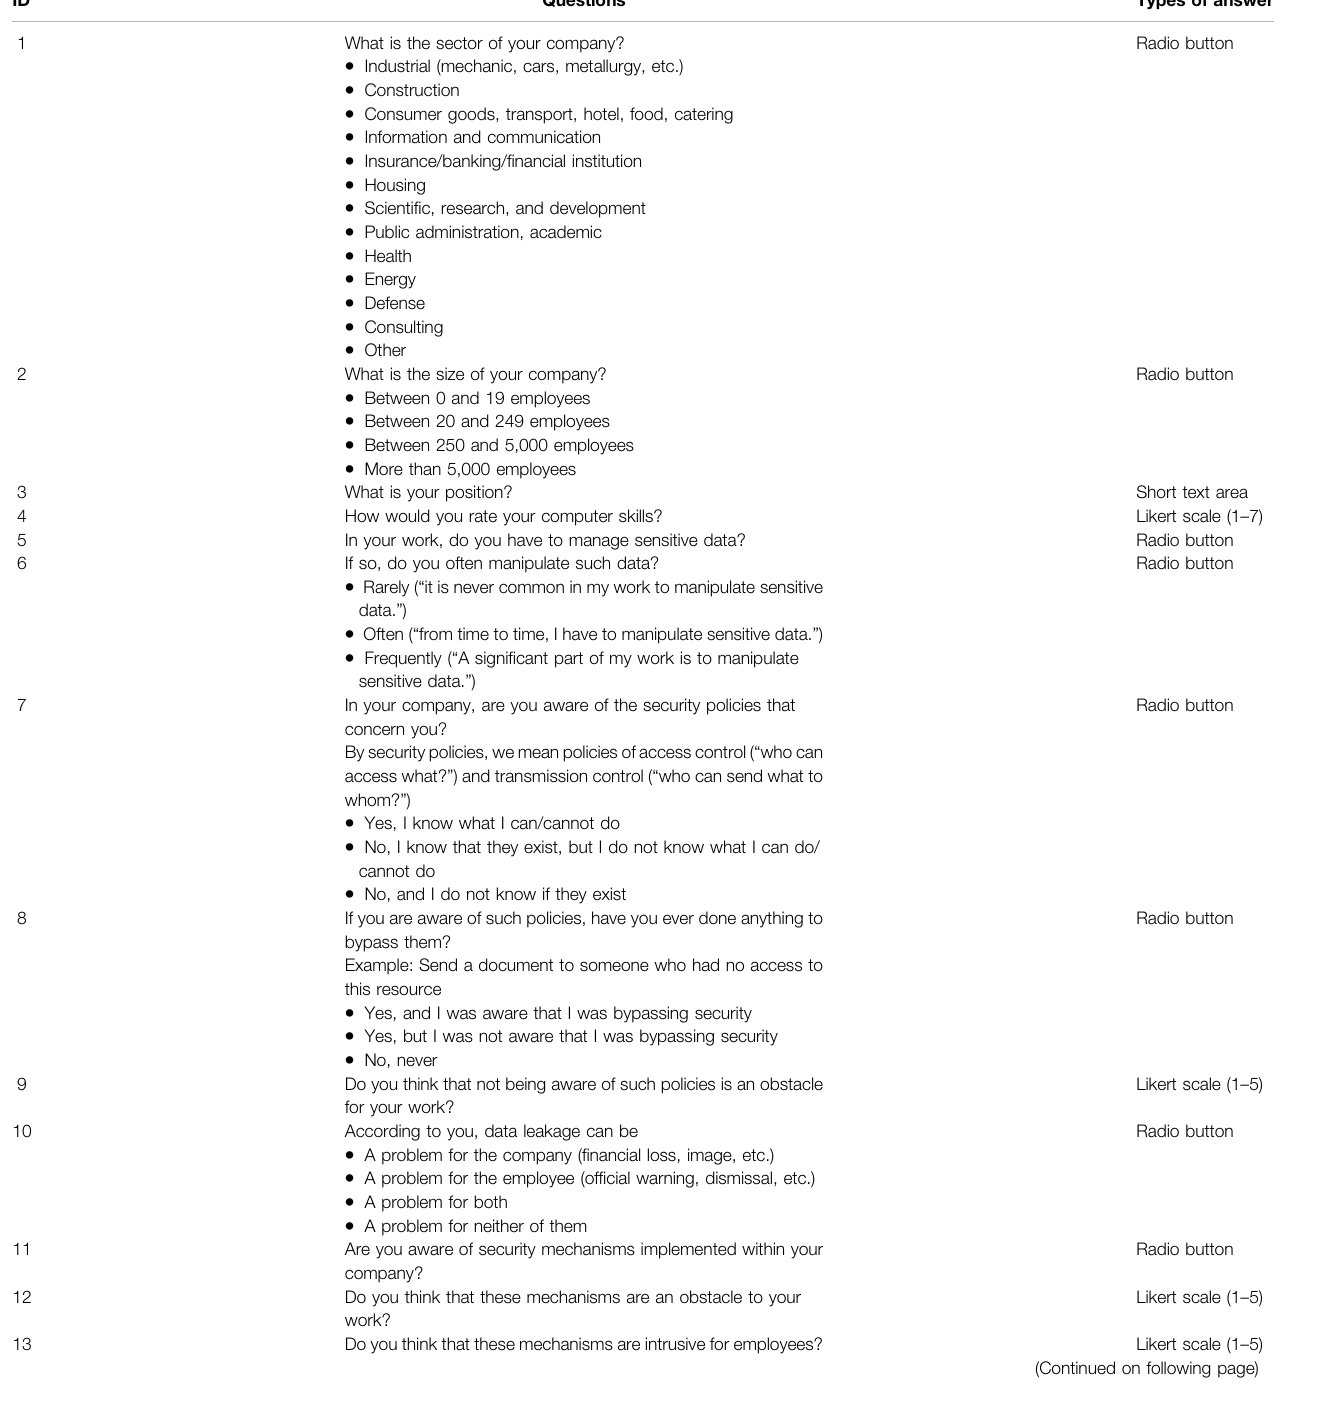
TABLE 2 | Questions and types of answers of our online